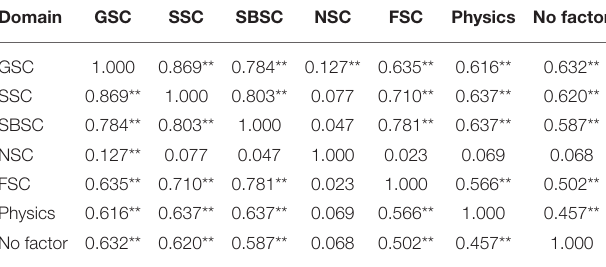
TABLE 4 | Discriminant validity of Chinese DAS 59. Domain P -value